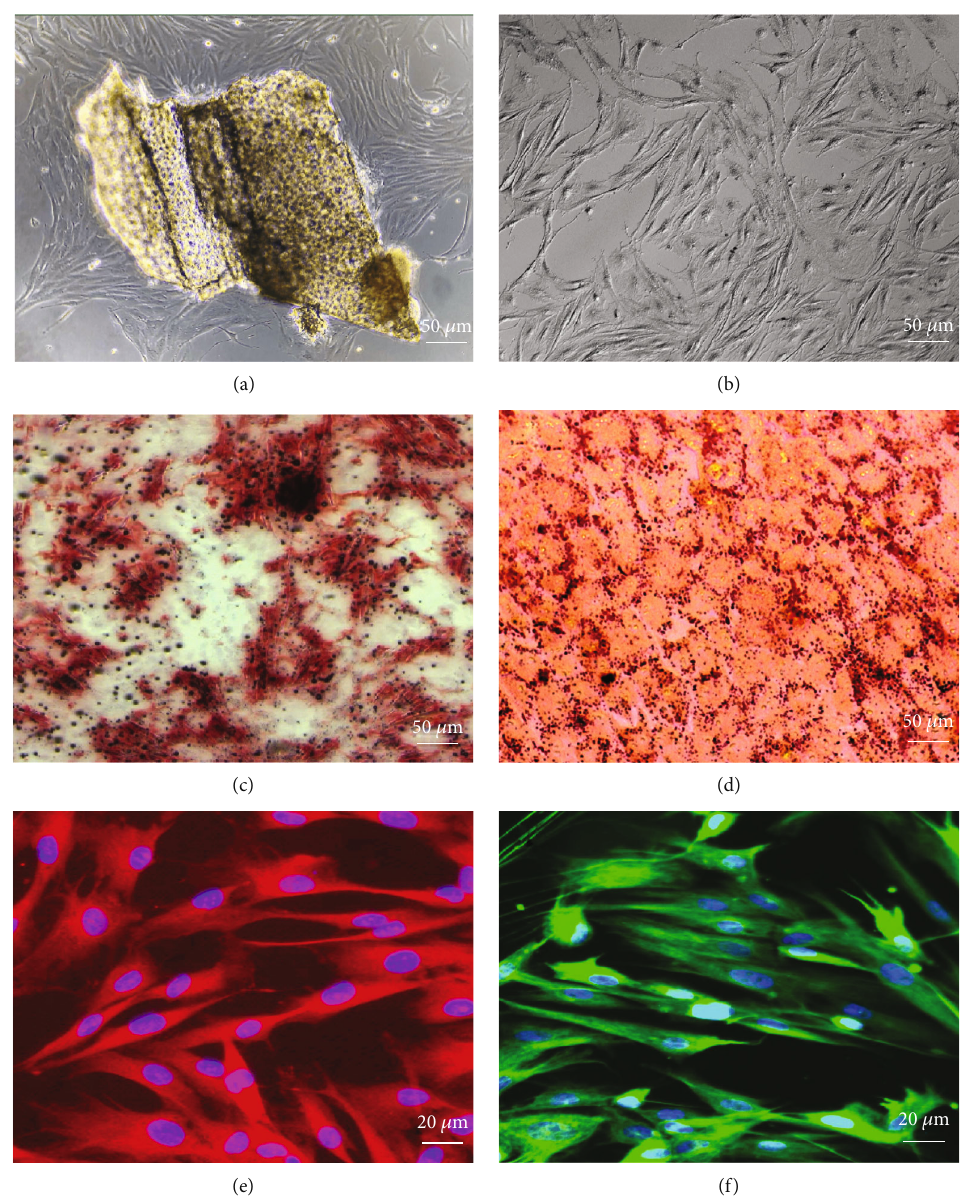
Figure 1: Isolation and identi fi cation of EMSCs. (a) P0 EMSCs. (b) P3 EMSCs. (c) Alizarin red staining shows calcium deposits and osteogenic di ff erentiation. (d) Oil Red staining of intracellular accumulated lipids shows adipogenic di ff erentiation. The EMSCs expressed the stem cell markers, including nestin (e) and vimentin